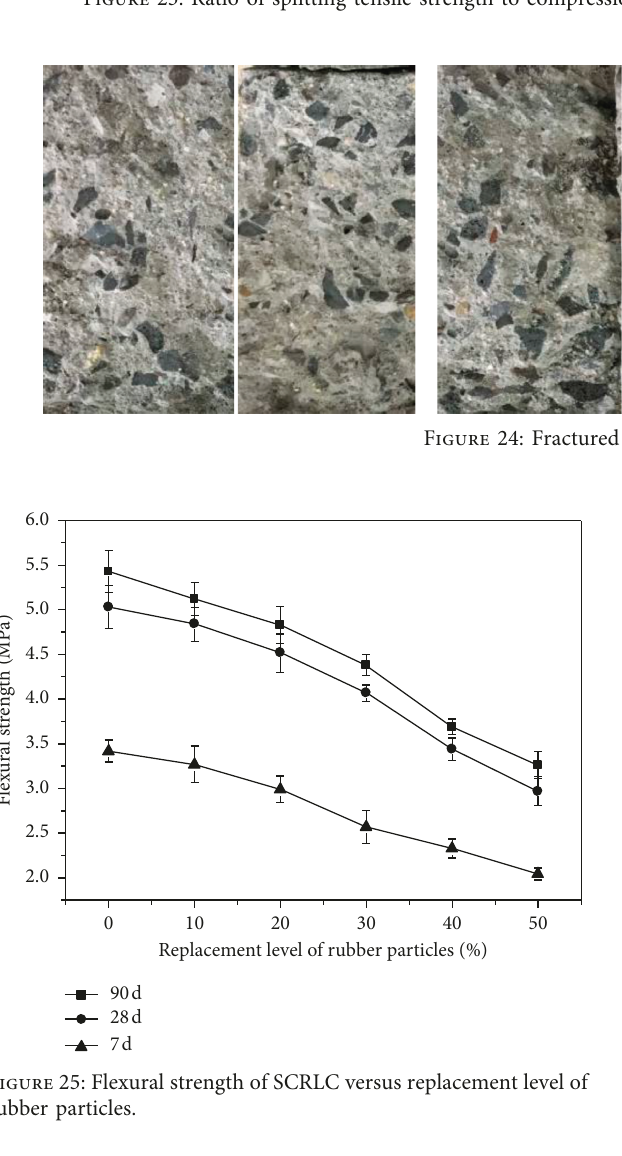
Figure 23: Ratio of splitting tensile strength to compression strength versus replacement level of rubber particles.